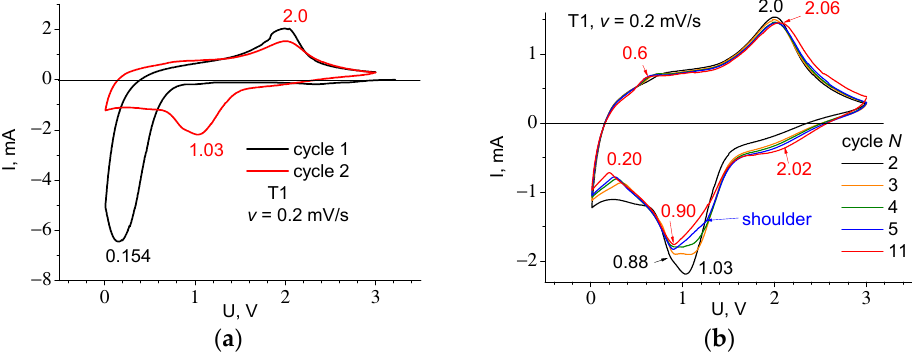
Figure 9. CVA curves recorded at sweep rate v = 0.2 mV/s for cycles: ( a ) 1 and 2 and ( b ) for 2 and 11. Cycle 2 in figures ( a , b ) are shown at different scales for easy comparison with other cycles.